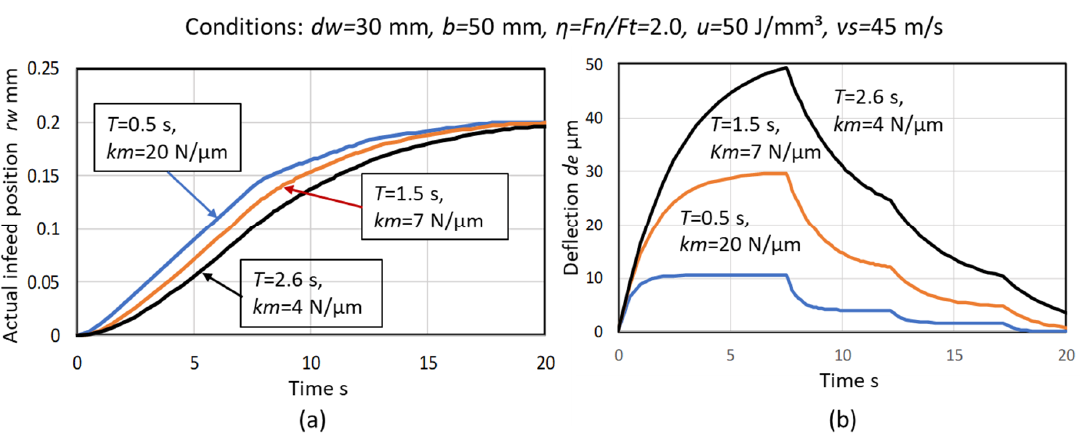
Figure 16. Influences of the time constant on the behaviors of process parameters. ( a ) Actual infeed position; ( b ) Deflection of grinding machine.